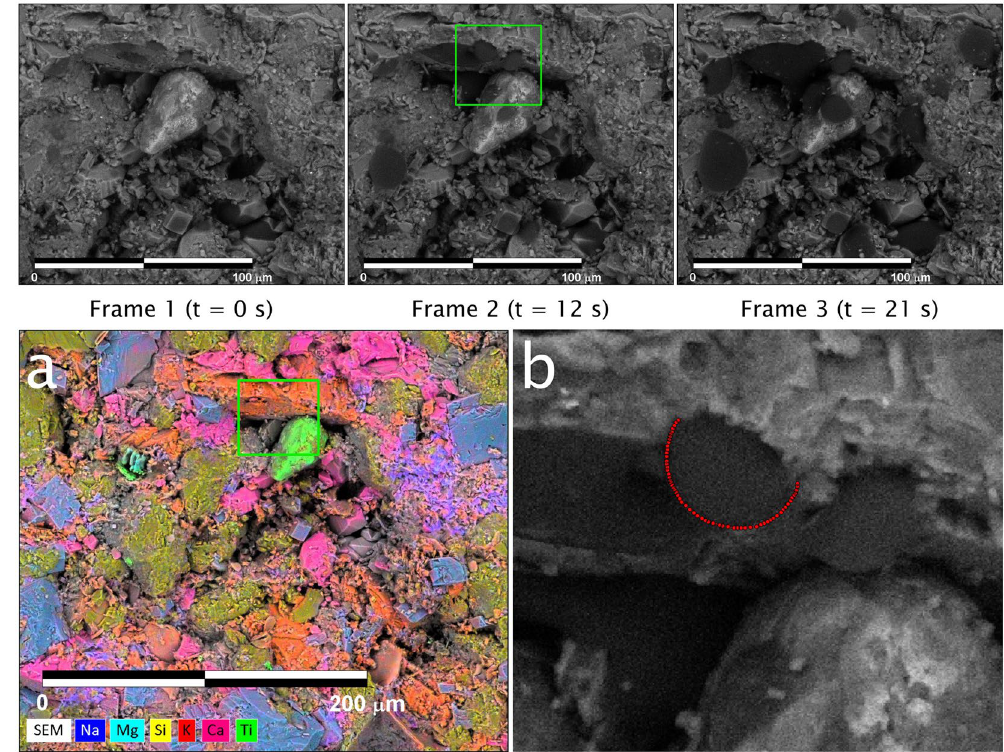
Figure 4. The first 3 frames are time-lapse images (compiled over 21 seconds) of a condensation/evaporation experiment performed on a second middle Bakken sample using the E-FESEM. Water condensation is seen to occur on a rutile grain (tear-drop shaped grain appearing in the lower half of the green box in Frame 2 and on a potassium feldspar grain whose edge can be seen in the upper half of the green box). The sample temperature was held at around 2.1 °C, and chamber pressure around ~700 Pa. The scale bar is 100 µ m. ( a ) Mineral identification through the use of elemental maps. Color coding for elements/minerals is the same as for Fig. 3b with the addition of titanium (light green) corresponding to rutile. ( b ) Zoom in of the green box in ( a ) showing an extracted droplet profile (red dotted line) for a micro-droplet condensed onto the surface of the potassium feldspar grain. The measured micro-droplet height and width is 6.8 µ m and 12.2 µ m, respectively. The calculated right and left contact angles are 94° and 97°,